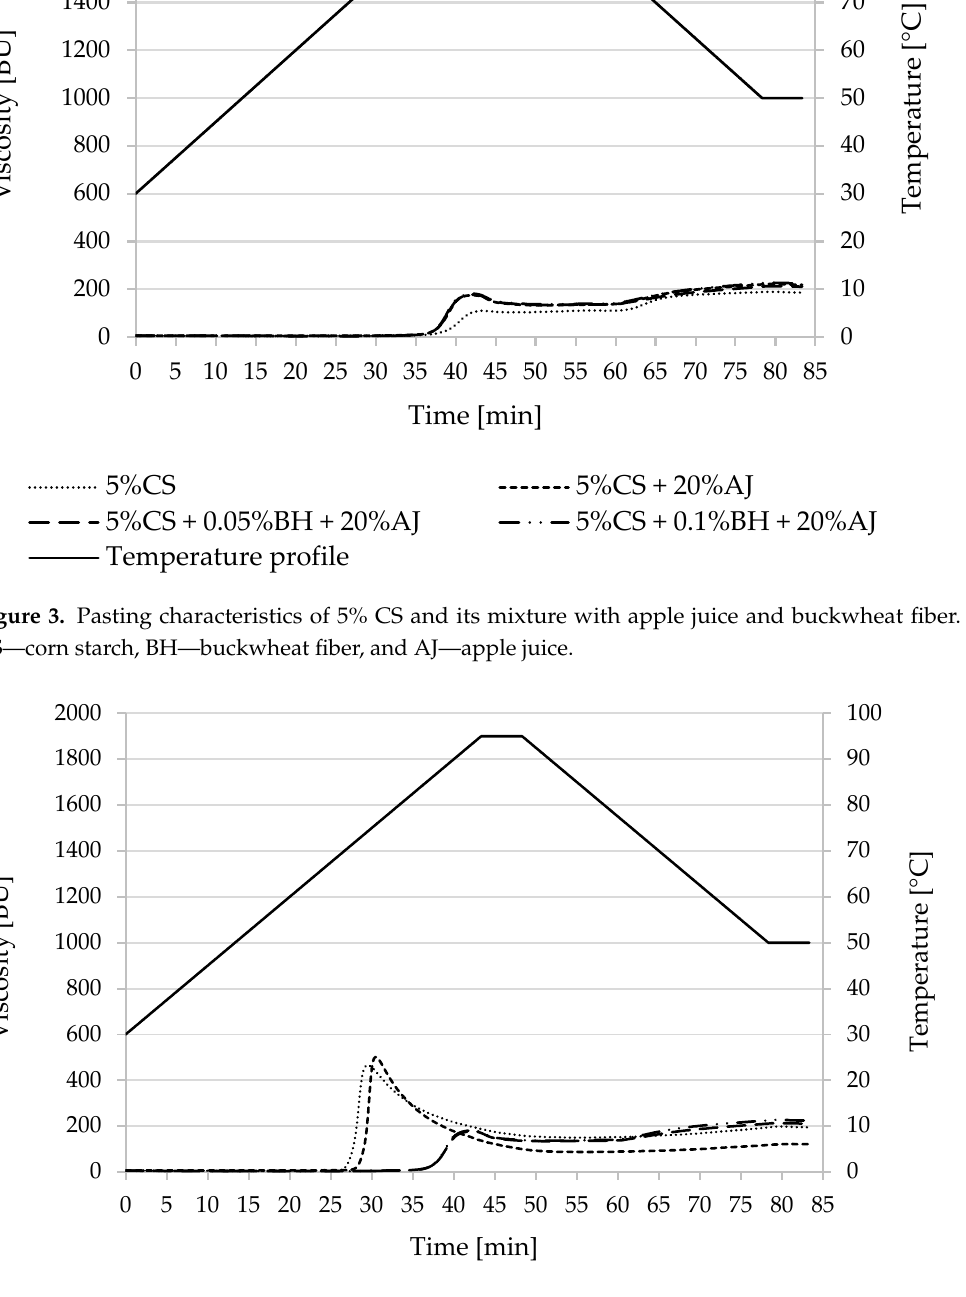
Figure 4. Pasting characteristics of 5% WCS and its mixture with apple juice and buckwheat fiber. WCS—waxy corn starch, BH—buckwheat fiber, and AJ—apple juice.